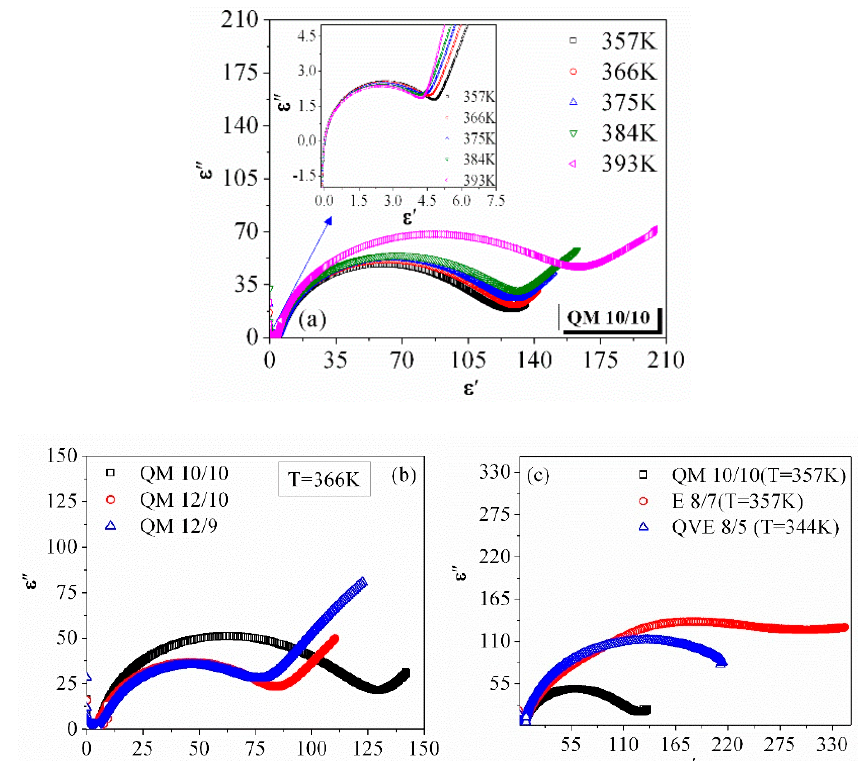
Figure 2. Cole–Cole plots for: ( a ) QM10 / 10 compound at five temperatures (as indicated) where the inset shows the high frequency contribution related to ITO electrodes; ( b ) three QMn / m compounds at T = 366 K; ( c ) three structurally di ff erent QVE8 / 5 (T = 344 K), E8 / 7 (T = 357 K), QM10 / 10 (T = 357 K) compounds.